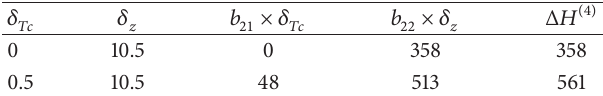
Table 3: The influence of engine fuel equivalent ratio to altitude